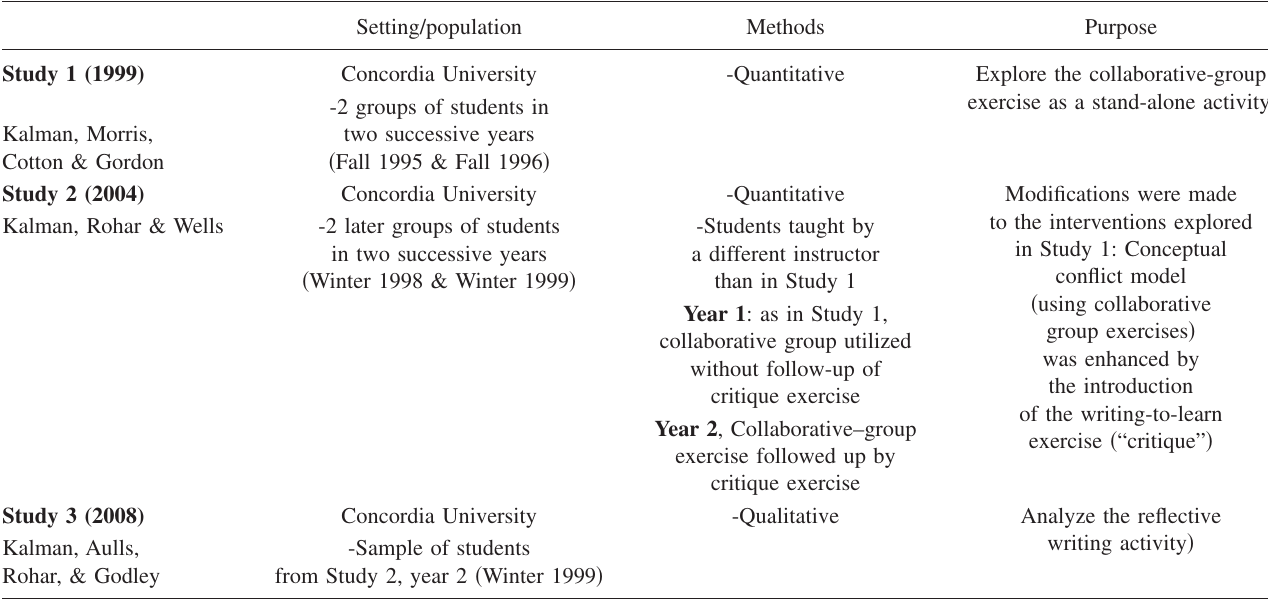
TABLE I. Studies comprising program of research